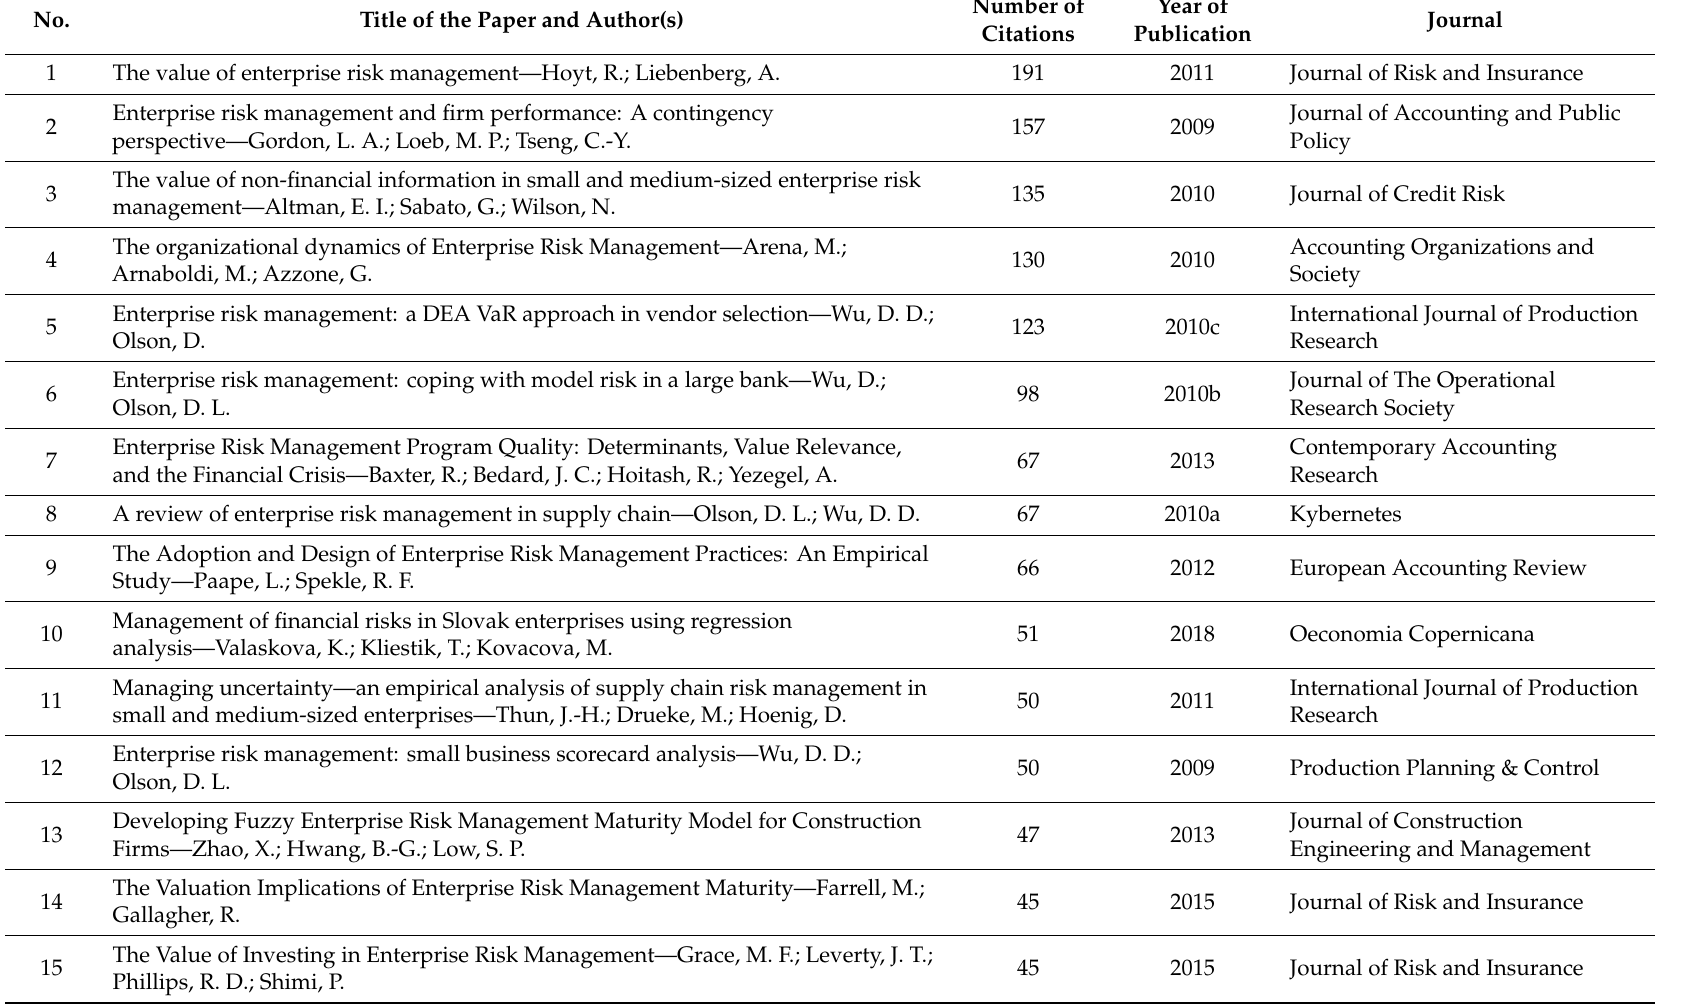
Table 4. Top 20 studies on ERM in descending order of their